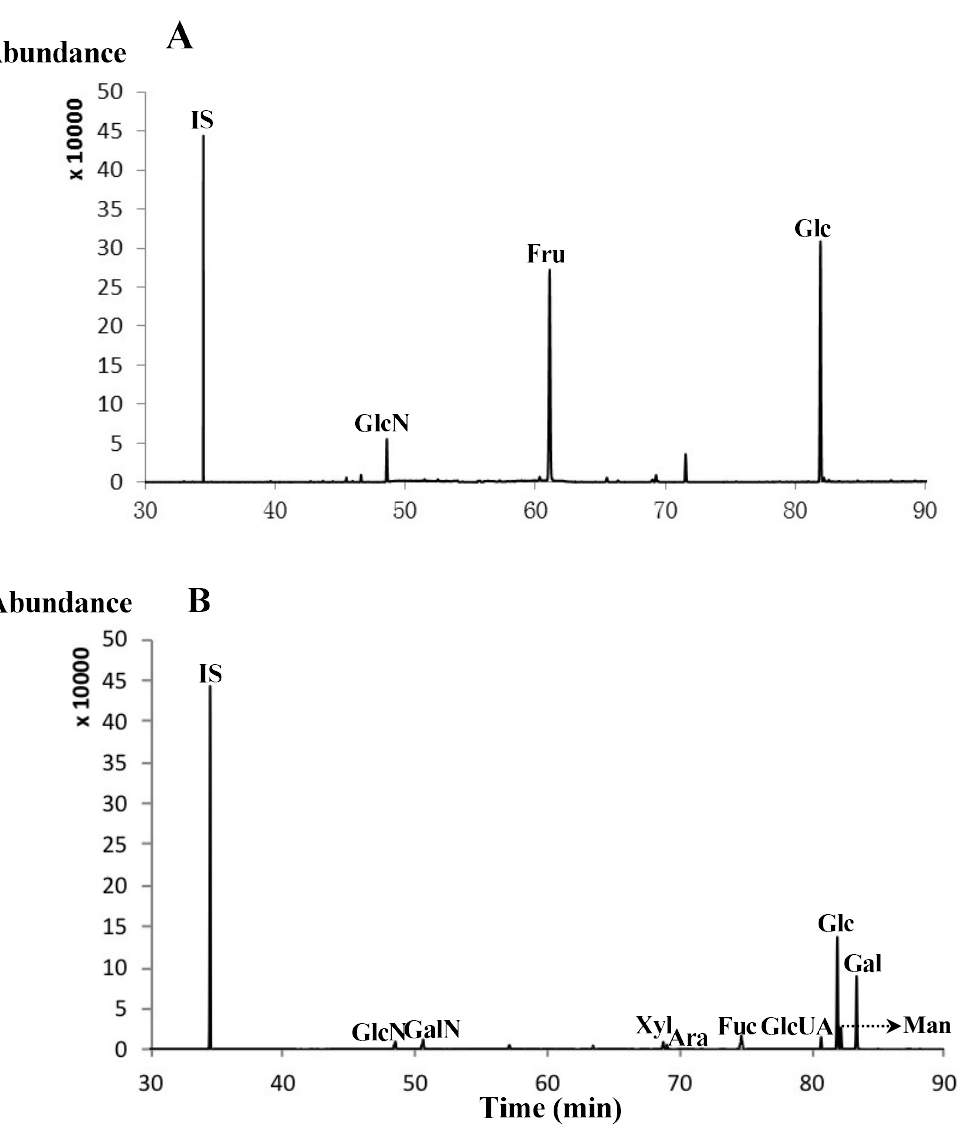
Figure 3. GC-MS chromatograms based on TMSD derivatives for free carbohydrates in the water extracts of A. asphodeloides ( A ) and full acidic hydrolysis products of G. ganoderma polysaccharides ( B ).